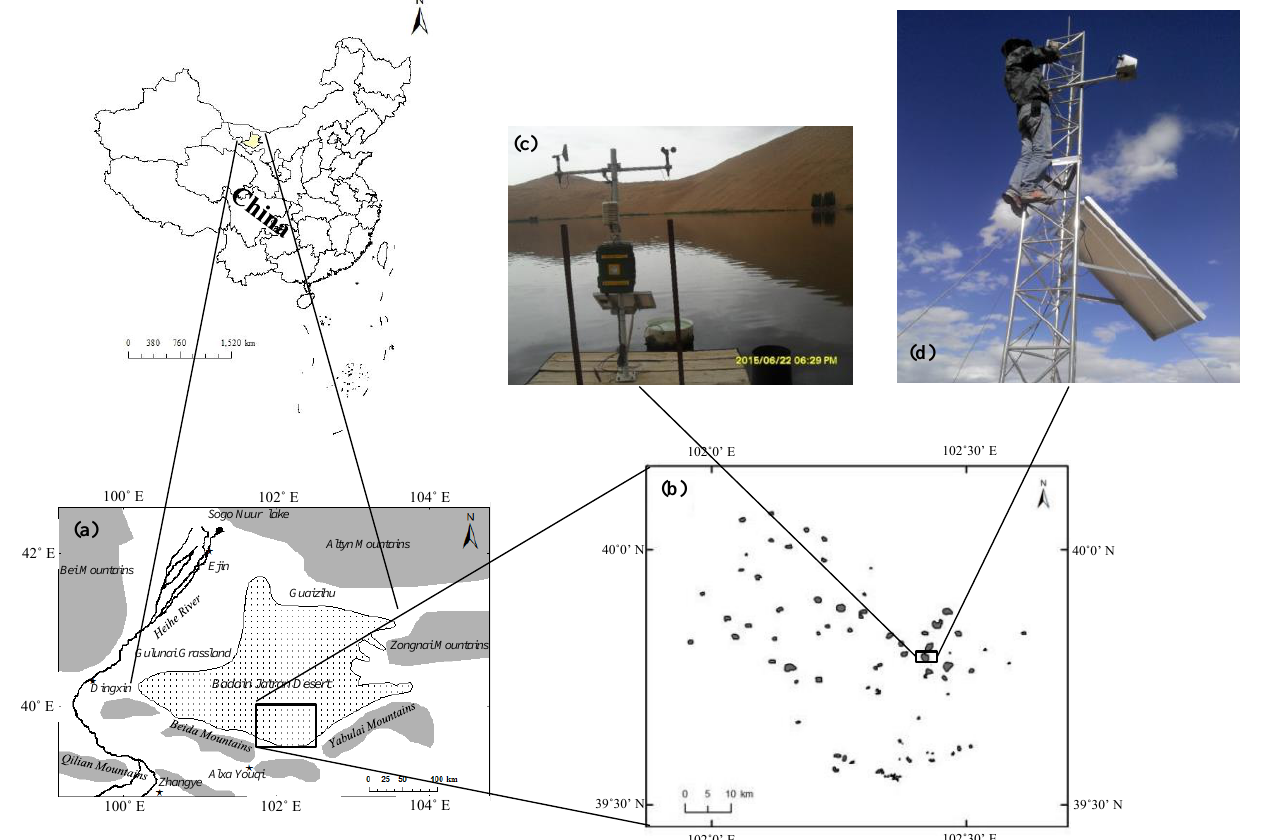
Figure 1. Location of the study area (a) , lakes (b) , weather station (c) and scintillometer (d) .